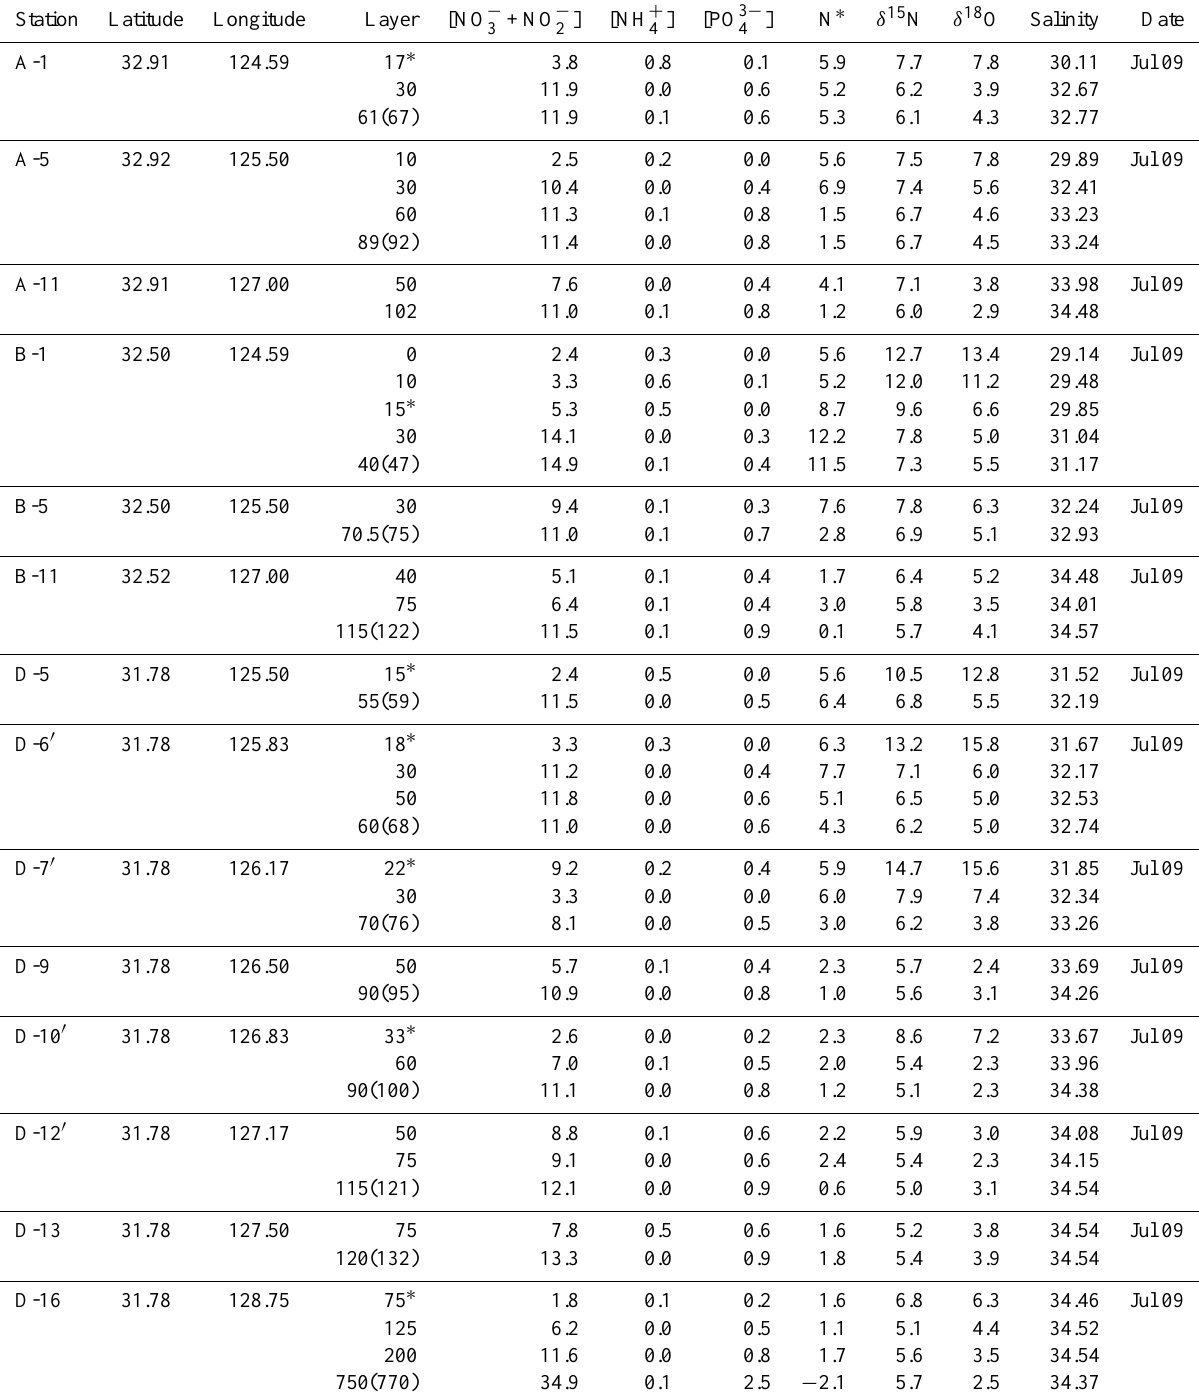
Table 2. Nitrate concentration and δ 15 N and δ 18 O in nitrate at each layer of the sampling stations in July, 2009. The depth (m) in parentheses indicates the water depth, and the layers with asterisks are the chlorophyll maximum.